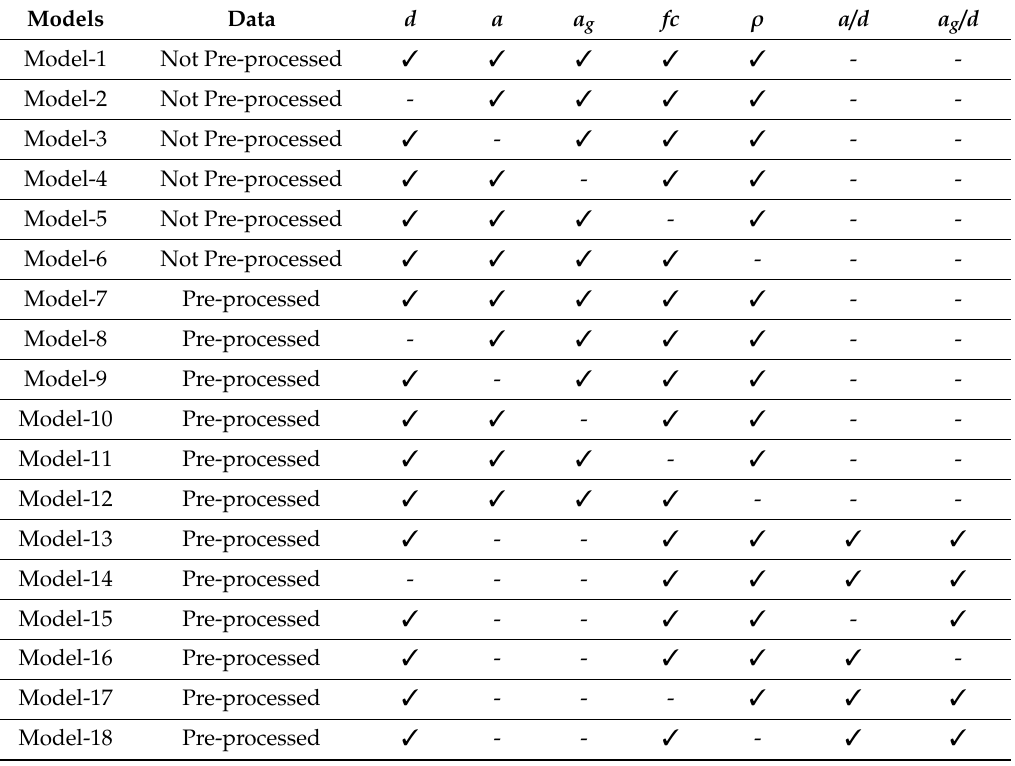
Table 1. The input combinations constructed for building the proposed hybrid estimator models for both pre-processed and non-preprocessed